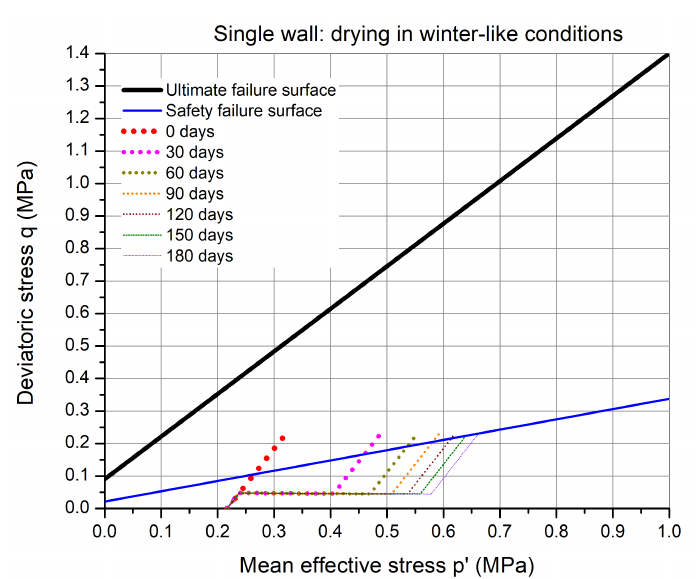
Figure 14. The stress path in p (cid:48) – q plane for the critical point in the wall at different duration of drying in winter-like environmental